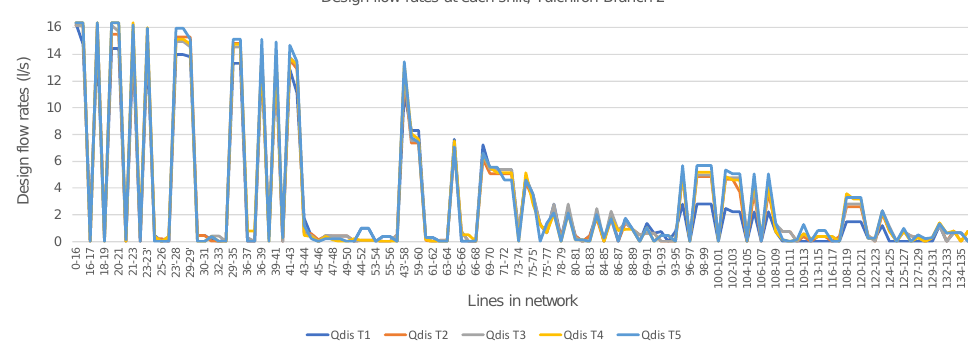
Figure 7. Results of the design flow rates at turns, in the Yulchirón 2 branch.